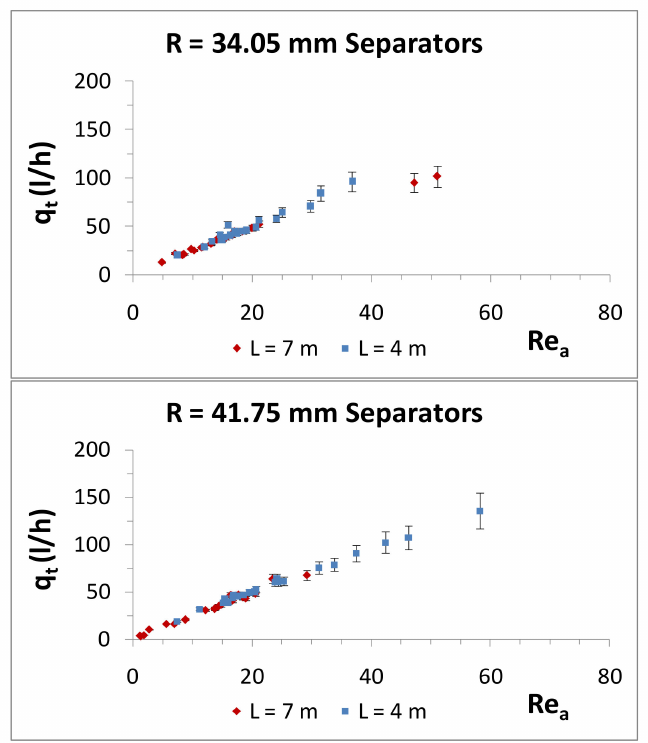
Figure 6. Relationship between the apparent Reynolds number Re a and the total flow q t (l/h) for the separators tested with different helix radiuses R (34.05 mm and 41.75 mm) and tube lengths L (4 and 7